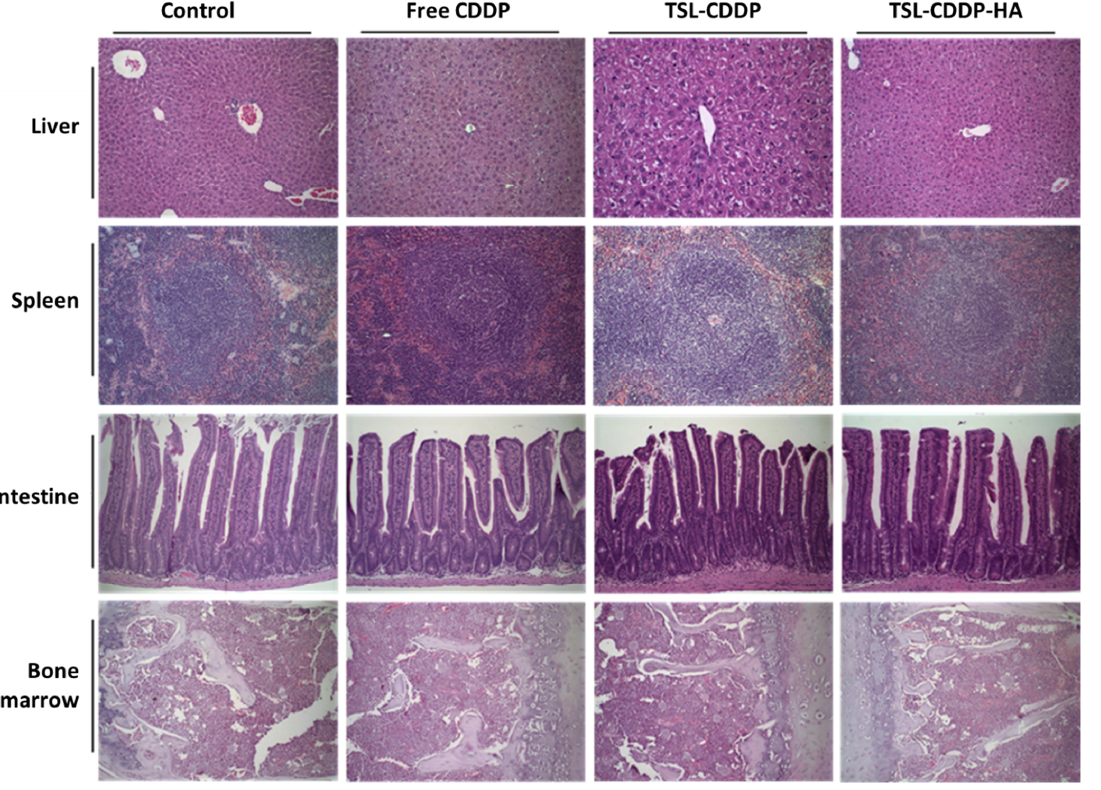
Figure 5. Photomicrographs of kidneys from Swiss mice treated with saline (control), free CDDP, TSL-CDDP and TSL-CDDP-HA. Arrow indicates the thickening of Bowman’s capsule, asterisk in- dicates inflammatory infiltrate and fibrosis. Hematoxylin & eosin staining. 40× magnification. In the group treated with free CDDP, inflammatory infiltrate and fibrosis were ob- served in the kidney in only one animal (Figure 5). Renal alterations caused by free CDDP were found in previous studies carried out by our research group only for a dose of 20 mg/kg [20]. For animals treated with TSL-CDDP, a focal glomerular lesion, indicated by a thickening of Bowman’s capsule (Figure 5), was observed in all animals evaluated. These results show a direct correlation between high blood urea levels and the presence of renal alteration, corroborating the high toxicity observed for cationic liposomes. However, this finding was only focal, indicating a possible recovery of the animals. This renal toxicity caused by the cationic formulation was successfully eliminated with the use of the